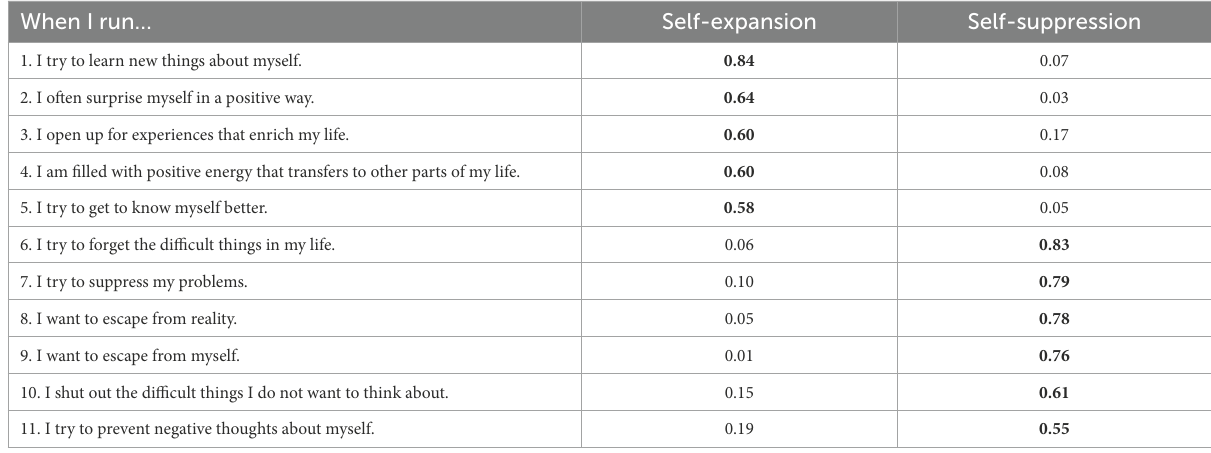
TABLE 1 Factor loadings for the escapism dimensions, self-expansion and self-suppression, from confirmatory factor analysis performed in Mplus 8.01. When I